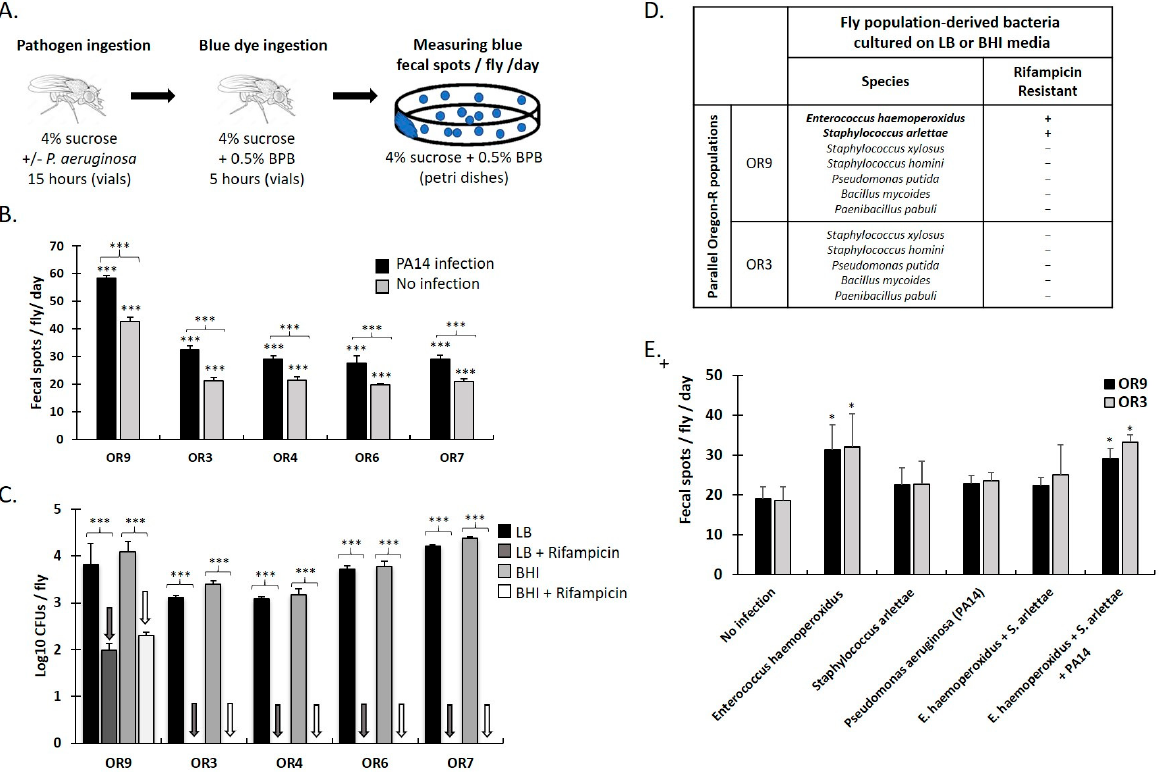
Figure 1. Ingestion of virulent bacteria and specific gut microbiota increase gut motility in Drosophila . ( A ) Defecation assay customized to examine the impact of PA14 on the defecation rate. At 15 h of feeding on PA14 or vehicle (4% sucrose) female flies were starved in empty fly vials for 5 h and then allowed to feed again for 5 h in fly vials containing 4% sucrose and 0.5% bromophenol blue (BPB) which colored fly food blue (at pH = 7). Conditioned flies were then transferred to plates feeding on 4% sucrose and 0.5% BPB for another day. Defecation rate was calculated as fecal spots per fly per day excreted by groups of 10 flies in 6 independent replicates. ( B ) Fecal spots per fly per day upon PA14 infection or without infection, of five populations of Oregon ‐ R (OR) flies, reared in parallel in the lab for one year. Statistical analysis was performed using two ‐ way ANOVA test with Tukey’s post ‐ hoc correction. Statistical significance was observed in all cases (*** p < 0.001) . ( C ) CFUs of intestinal bacteria per fly, shaped on LB or BHI media, in the absence or presence of rifampicin. Statistical analysis was performed using two ‐ way ANOVA test with Tukey’s post ‐ hoc correction. Statistical significance was observed in all cases (*** p < 0.001) . ( D ) Bacterial species found in adult female flies of the OR9 and OR3 populations feeding on LB or BHI media, with and without rifampicin. Extraction of genomic DNA from single colonies and sequencing followed by BLAST search of the sequences, revealed five rifampicin ‐ sensitive bacterial species, common to both OR9 and OR3 and two rifampicin ‐ resistant strains ( E. haemoperoxidus and S. arlettae ), exclusive to OR9. ( E ) Fecal spots per day per female of the OR9 and OR3 populations, following ingestion of either PA14 or rifampicin ‐ resistant strains E. haemoperoxidus or S. arlettae , alone or in combinations, in six independent replicates. Statistical analysis was performed using the Mann–Whitney U test. Statistical significance is indicated as * p < 0.05. All error bars represent standard deviation of the mean.